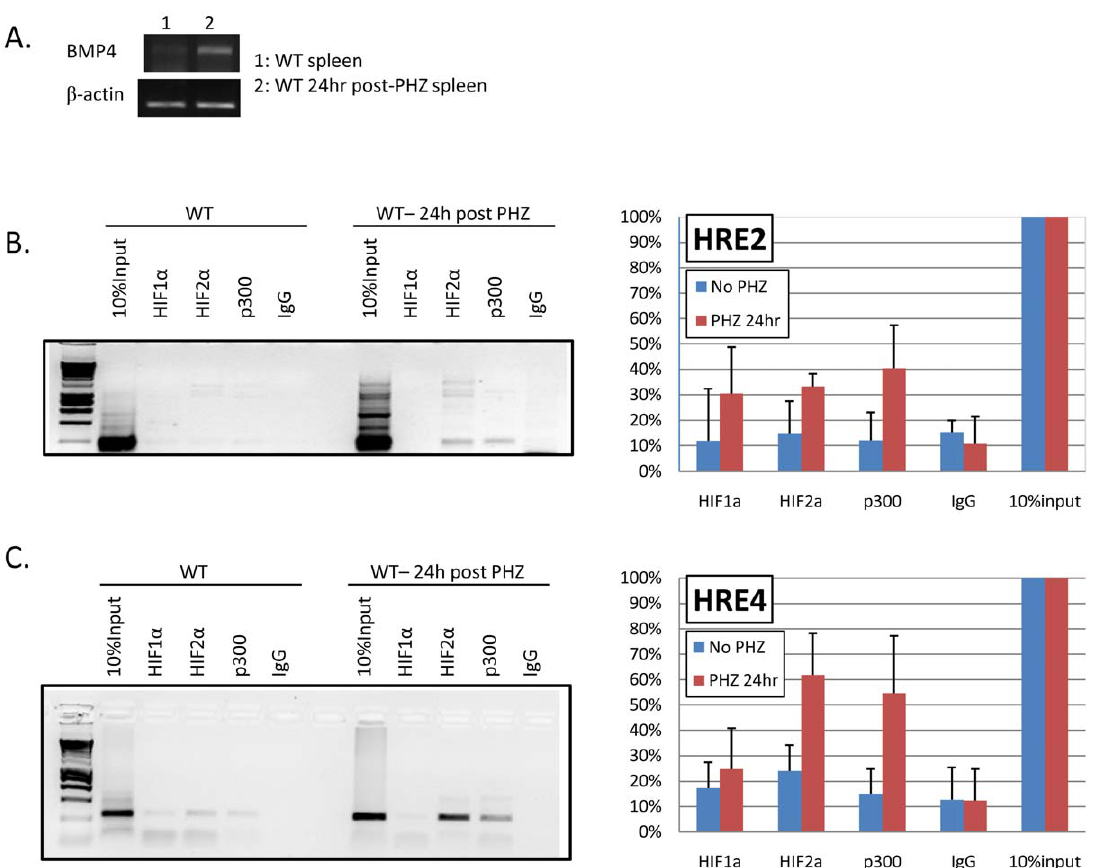
Figure 5. Binding of HIF and p300 to the BMP4 locus is induced by anemia. (A) RT-PCR analysis of BMP4 or b -actin (control) expression in primary spleen cells isolated from mice at 24 hours post induction of acute hemolytic anemia with phenylhydrazine (PHZ) and untreated mice. (B) Spleen cells were analyzed by ChIP assay using anti- HIF1 a , HIF2 a , p300 or IgG antibodies. PCR was performed with primers amplify HRE-2 (B) and HRE-4(C). Representative gel data are shown. The relative intensity of PCR products normalized to the input lanes is shown by combining data from three individual ChIP assays.